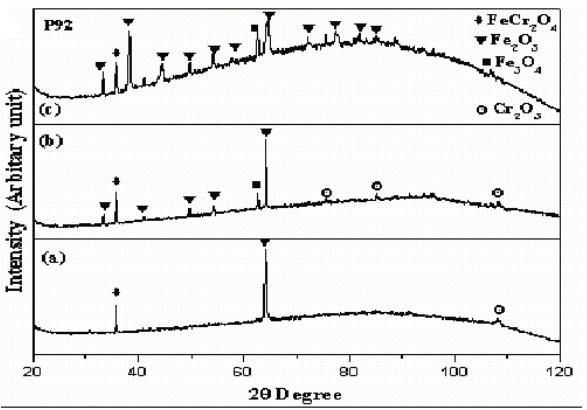
Figure 4. XRD-Pattern of P92 alloy after oxidation in air (a) 873 K (b) 973 K and (c) 1073 K for 1000 h.